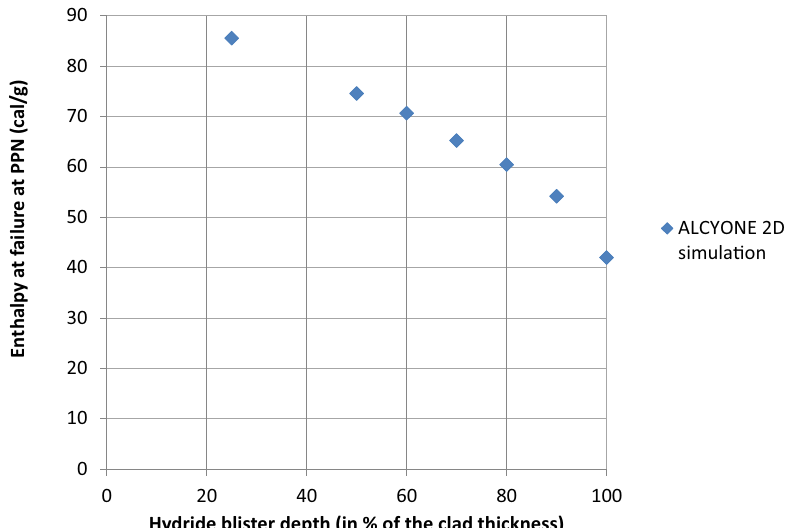
Fig. 9. Calculated evolution of the enthalpy at failure in function of the hydride blister depth (in % of the clad wall thickness), based on the REP-Na8 test